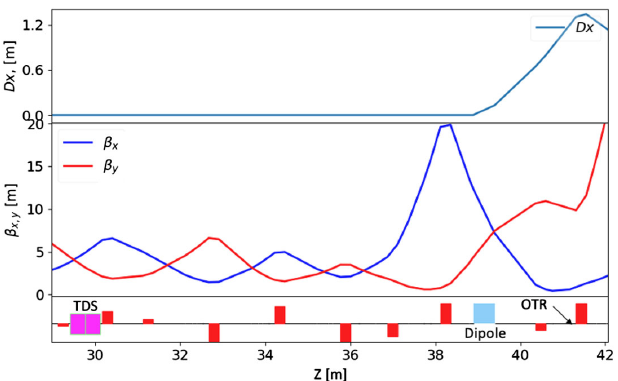
FIG. 6. Special optics for the slice energy spread measure- ment. Optics is shown from the matching point. Note, β -functions are calculated in linear approximation without any collective